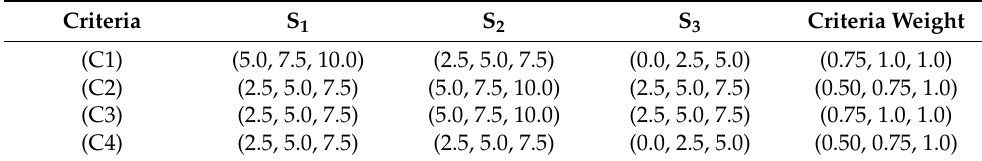
Table 8. Fuzzy numbers attributed to each supplier evaluation.